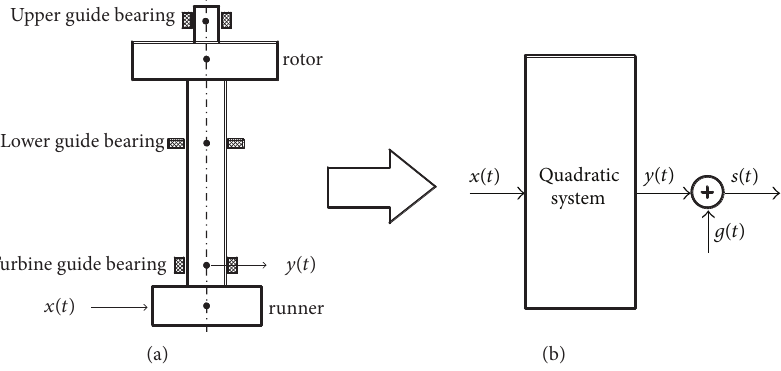
Figure 1: Hydroturbine shaft system and quadratic Volterra